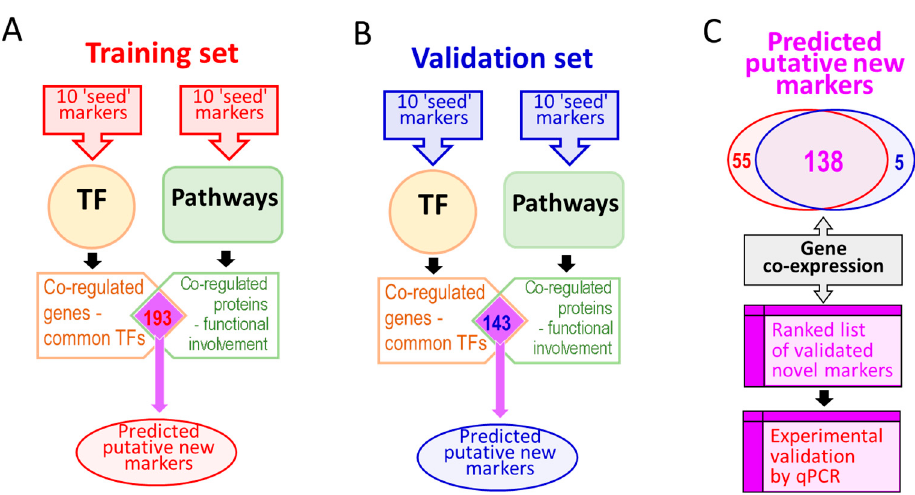
Figure 1. A summary of the methodology used to expand the range of molecular biomarkers of colorectal cancer (CRC). Panel ( A ): A training set of 10 known CRC markers is used to interrogate transcription factor (TF) databases and, separately, functional pathways databases. Panel ( B ): Validating the procedure using a set of 10 completely different markers with the same procedure as in ( A ). Panel ( C ): The virtually identical set of novel markers identified in ( A ) and ( B ) is further ranked using gene co-expression information to prioritize the most likely putative markers for further validation using quantitative PCR analysis of surgically resected CRC tissues.